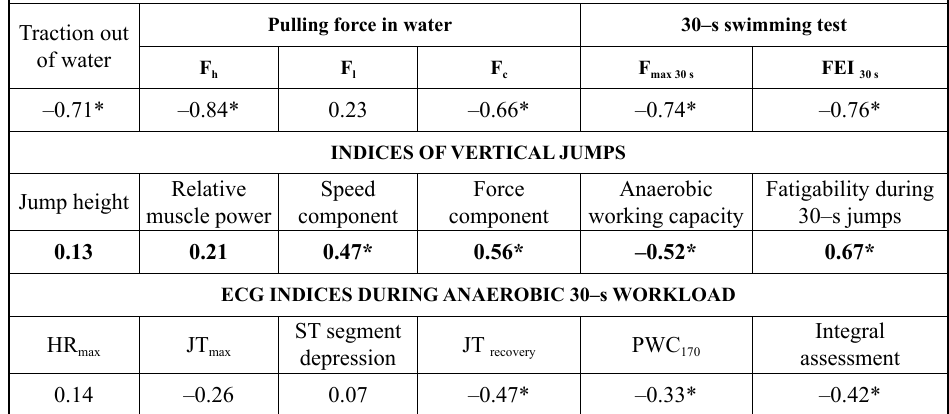
Note. * – statistically significant values of the correlation (p <